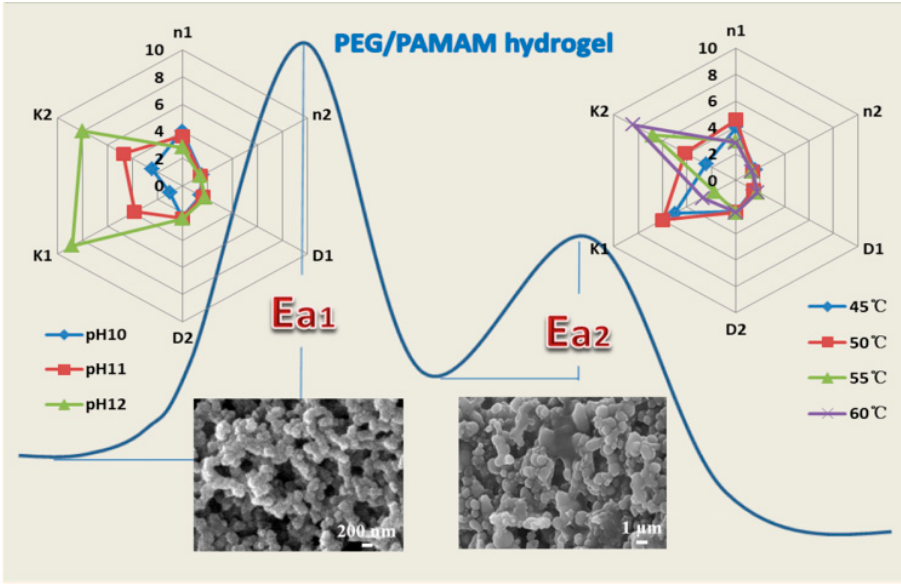
Figure 5. Schematic diagram of the two dynamic growth modes of PEG/PAMAM hydrogels.